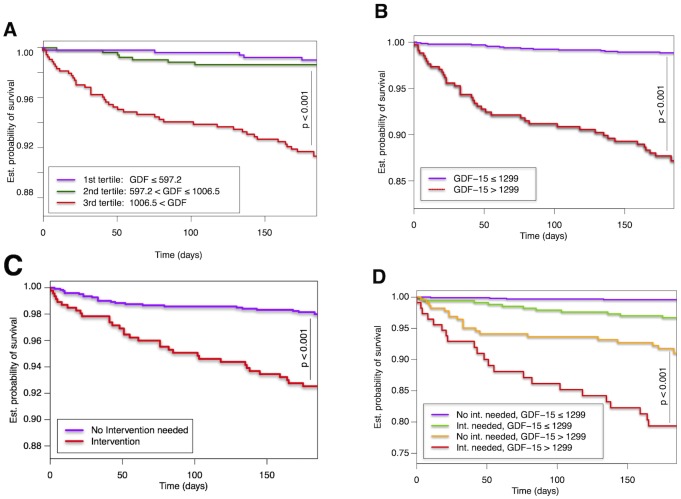
Cumulative survival curves according to various strata.Presented are Kaplan-Meier survival curves in patients presenting with chest pain for the combined primary endpoint of death and non-fatal myocardial infarction within 6 months after presentation according to A) tertiles of GDF-15 levels and B) levels dichotomized using an optimized cut-off of 1298.9 pg/mL and C) need for intervention D) the optimized cut-off and need for intervention.